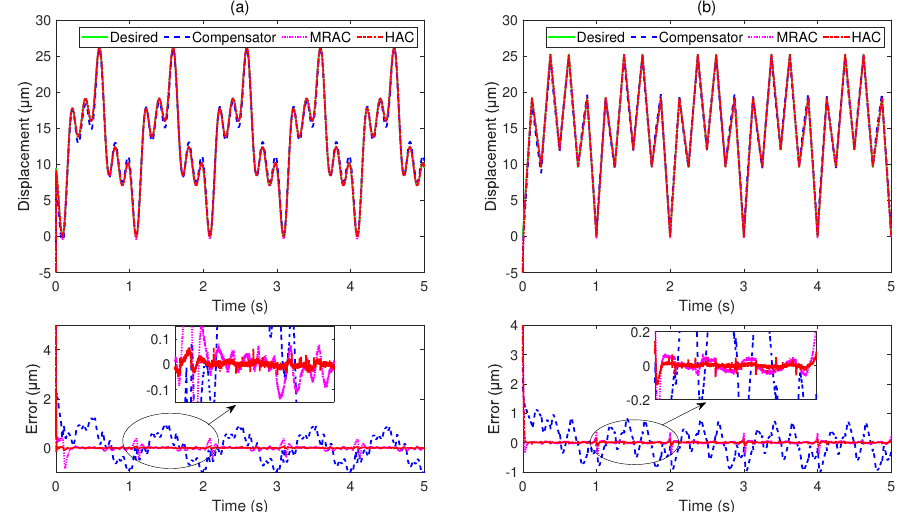
Figure 8. Tracking performance of the HAC approach in comparison with the compensator and MRAC under different complex reference trajectories: ( a ) mixed sinusoidal signal; ( b ) mixed triangular